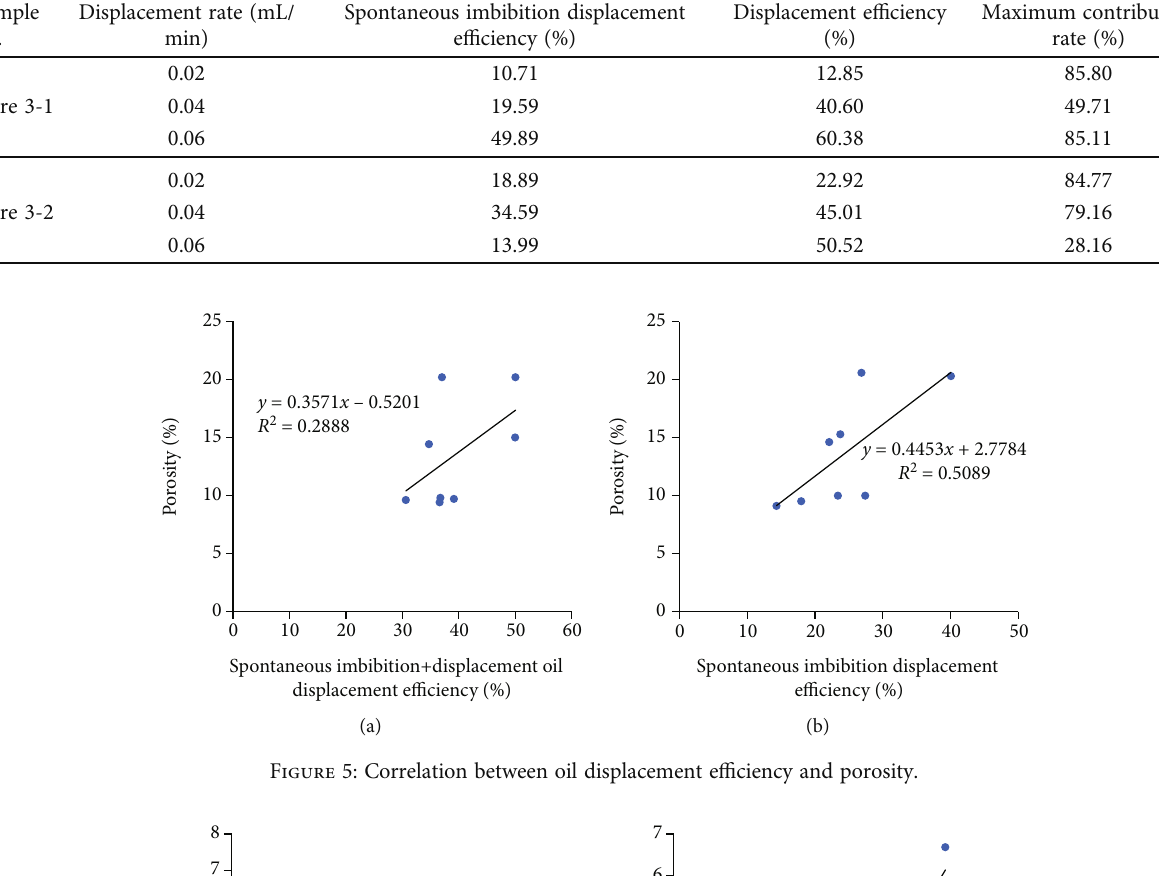
Table 3: Oil displacement e ffi ciency and maximum contribution rate.